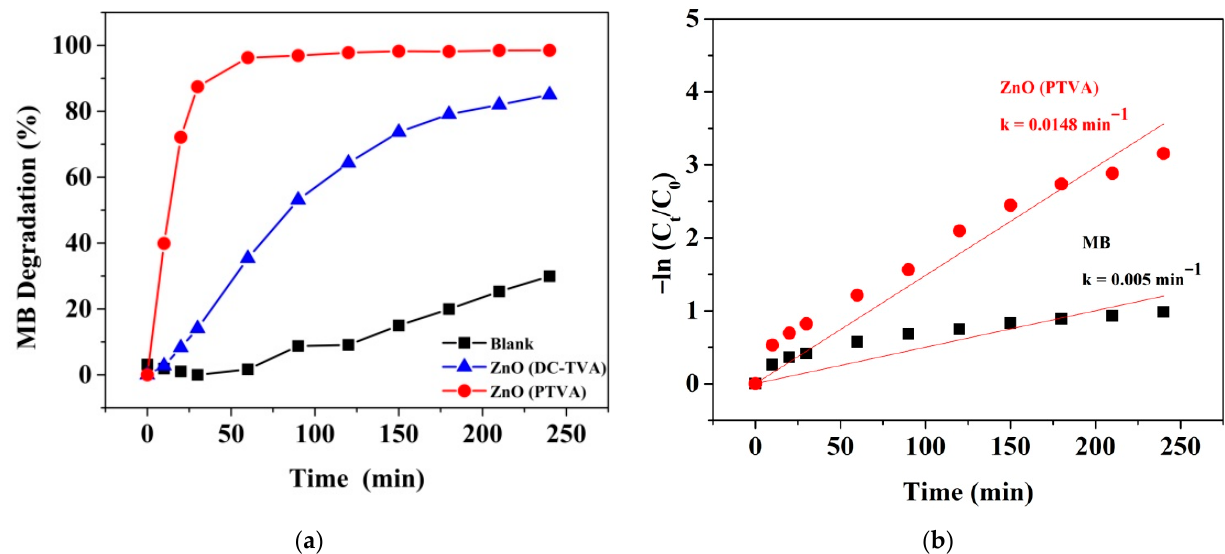
Figure 6. ( a ) The photocatalytic degradation plots of MB dye in absence or presence of nanostruc- tured ZnO samples under UV light. ( b ) Linear kinetic-fitting curves with the degradation-rate constants for the UV-induced dissociation of MB by photocatalysts.